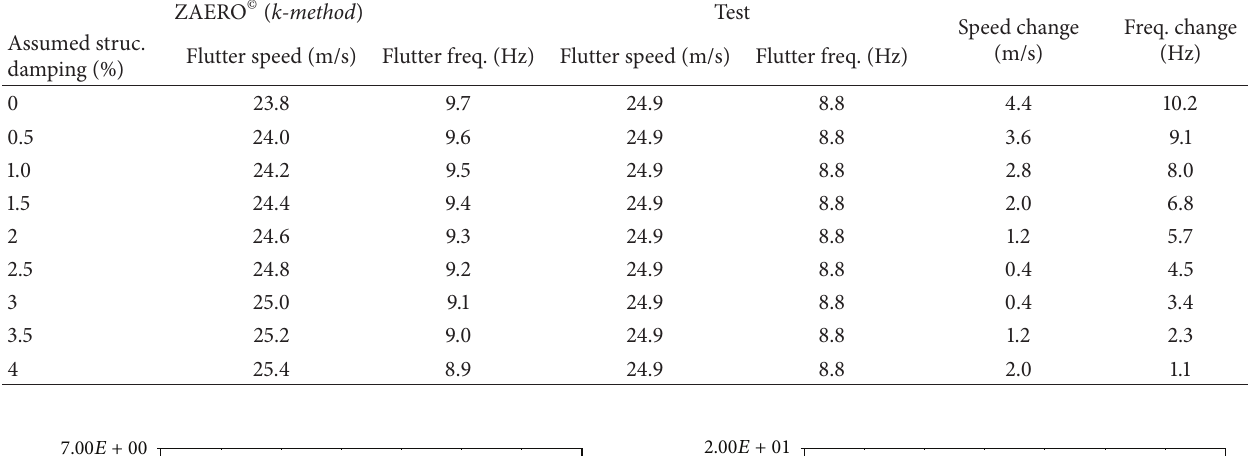
Table 6: Comparison of wind tunnel flutter test with flutter analysis for the rectangular plate for k-method . ZAERO © ( k-method ) Test (Hz)Assumed struc.